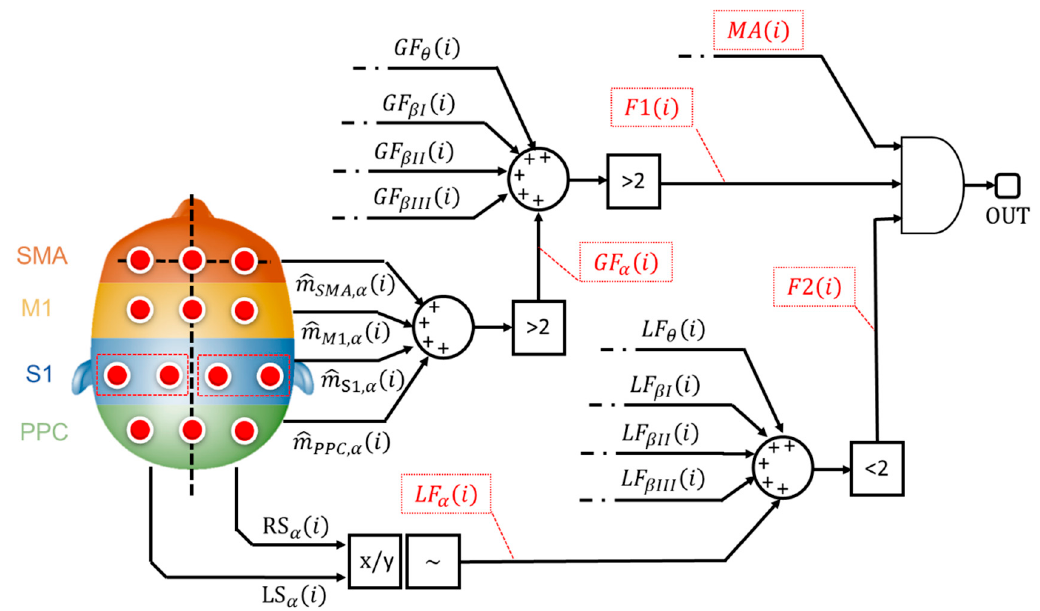
Figure 4. Logic network-based classifier. The flags that contribute to the classification stage are reported in red dotted boxes.